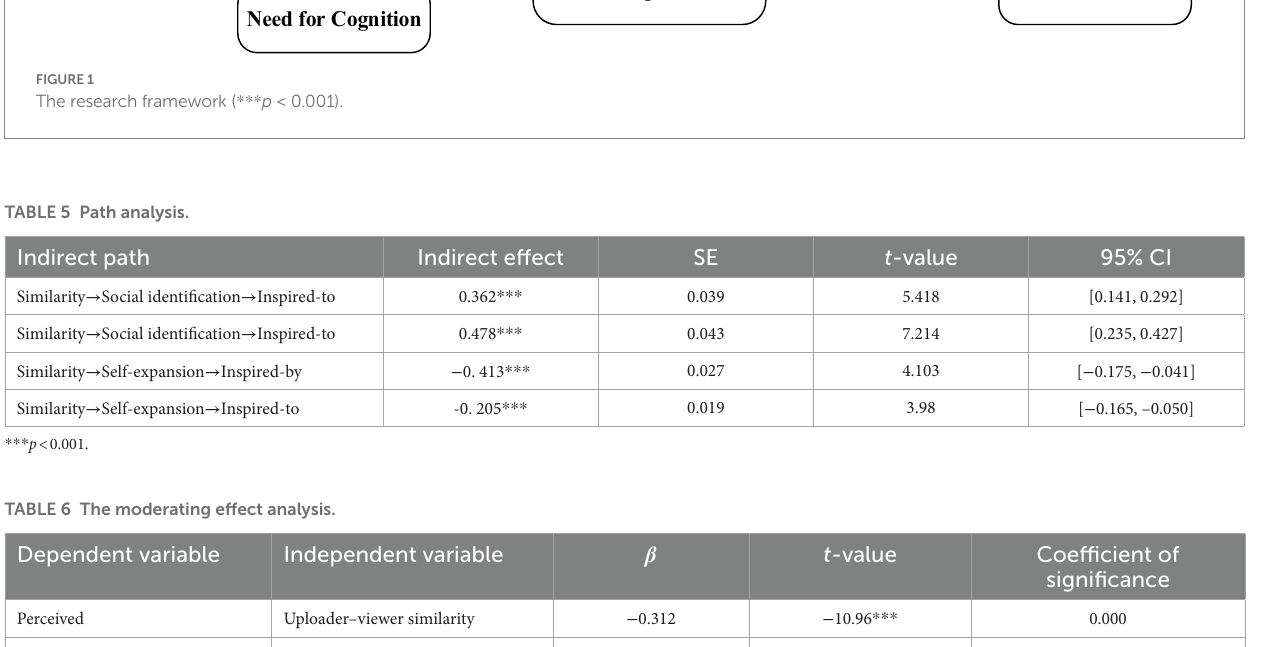
FIGURE 1 The research framework ( *** p <